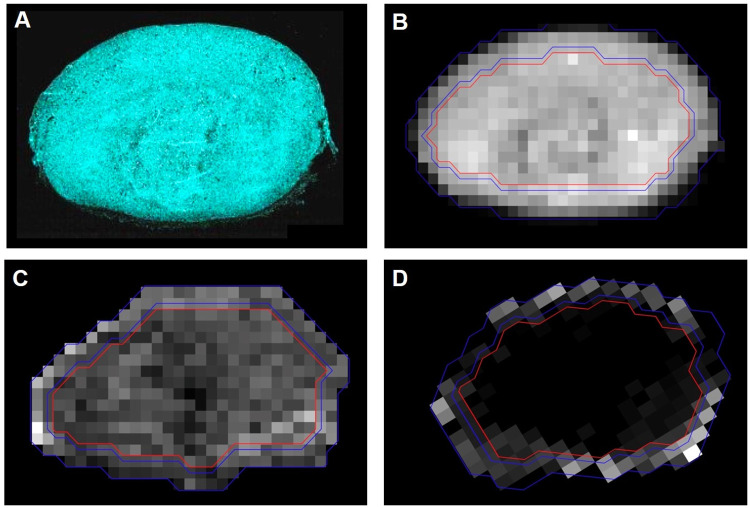
Quantification of histological and MRI measures of a tumor in the control group.(A) DAPI staining. (B) The staining density map of DAPI staining shown in (A). Also shown are the corresponding ADC (C) and Cmax (D) maps at the center of the same tumor. Two blue lines indicate a 0.2 mm-wide band immediately inside of the boundary of the tumor for the rim ROI, while the red line delineates the core ROI.